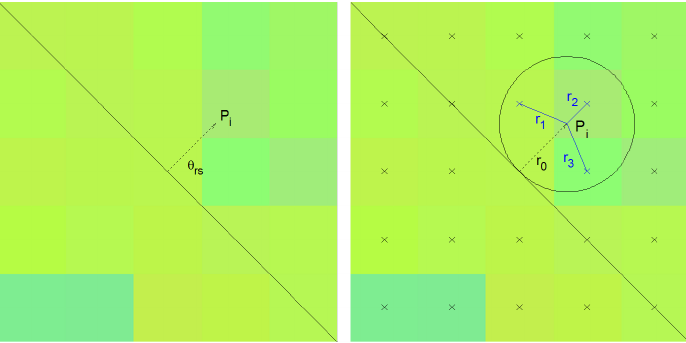
Figure 3. Selection of neighboring pixels for updating the state of cell i